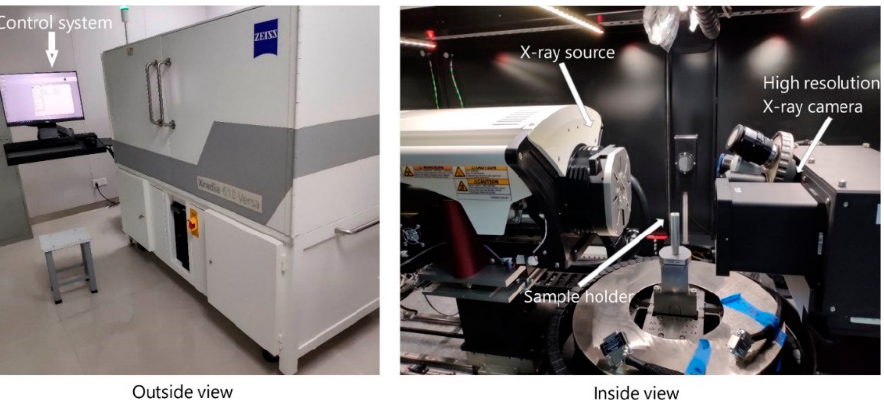
Figure 8. X-ray computed tomography machine.